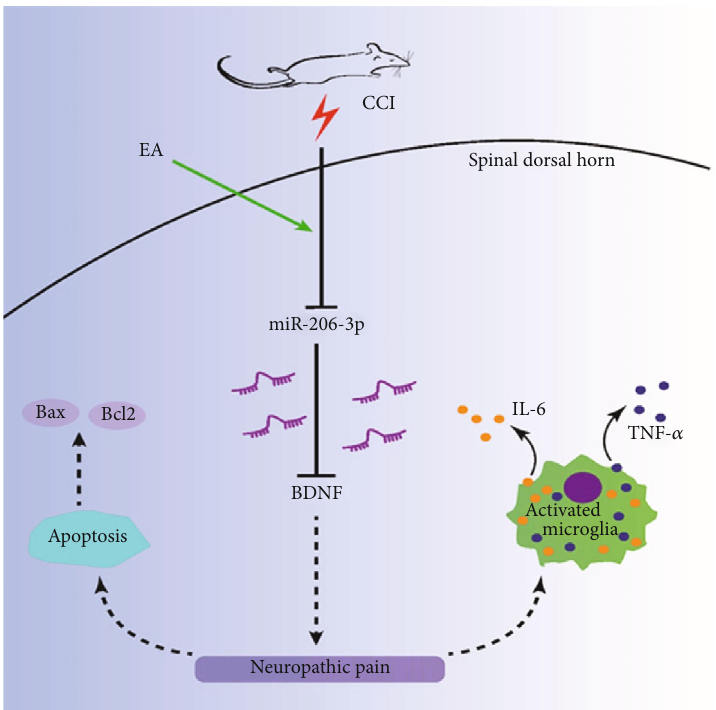
Figure 7: The summary fi gure for this study. Electroacupuncture exerts analgesic e ff ect by activating miR-206-3P and inhibiting